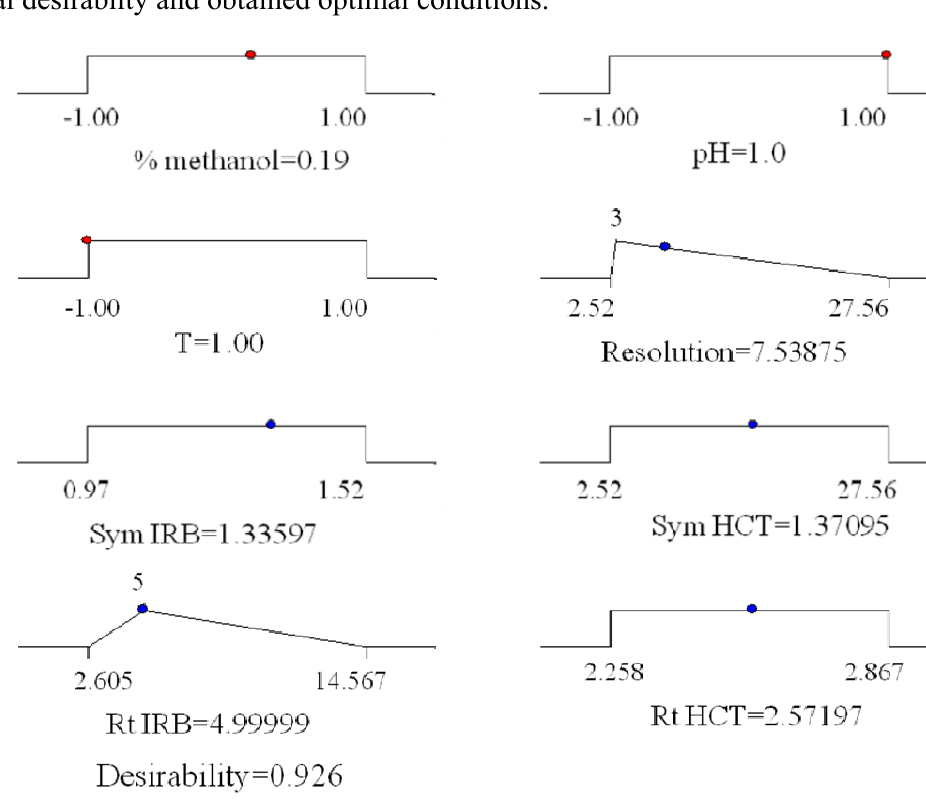
Figure 5. Graphical representation of the constraints accepted fot the determination of global desirabilty and obtained optimal